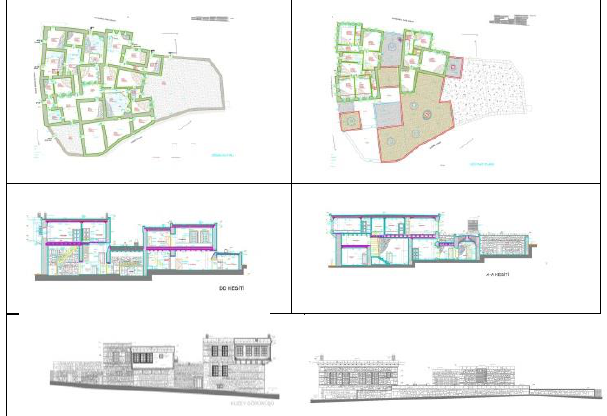
Figure 9. 2D Restitution Drawings